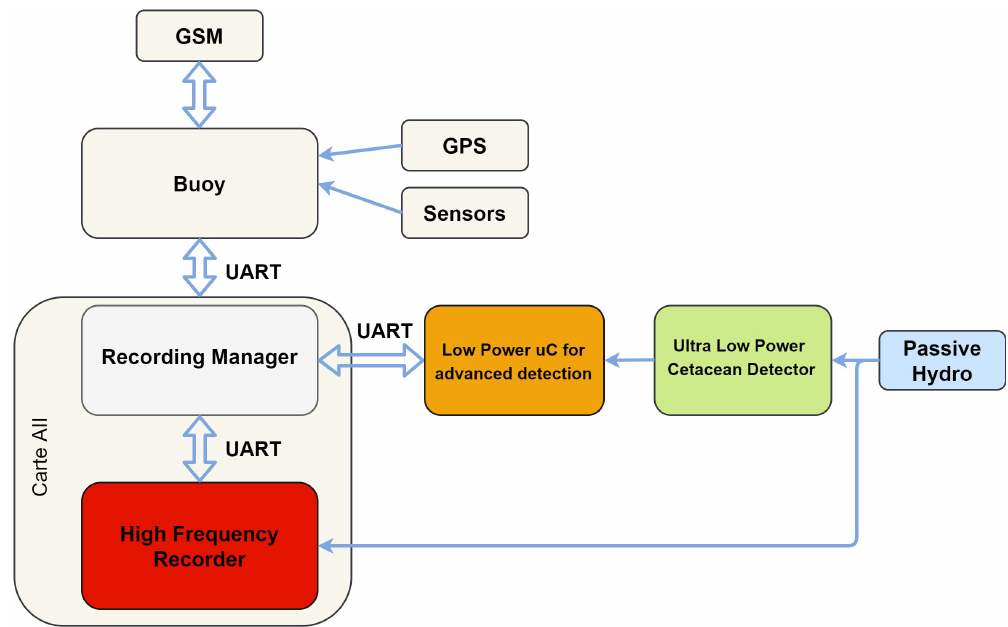
Figure 4. Cetacean Monitoring